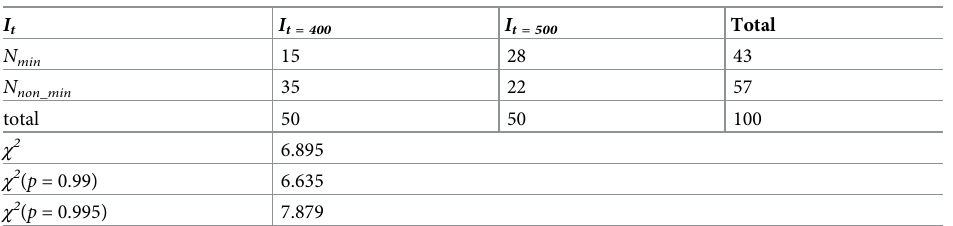
Table 3. Sample frequency contingency table of N min and I t